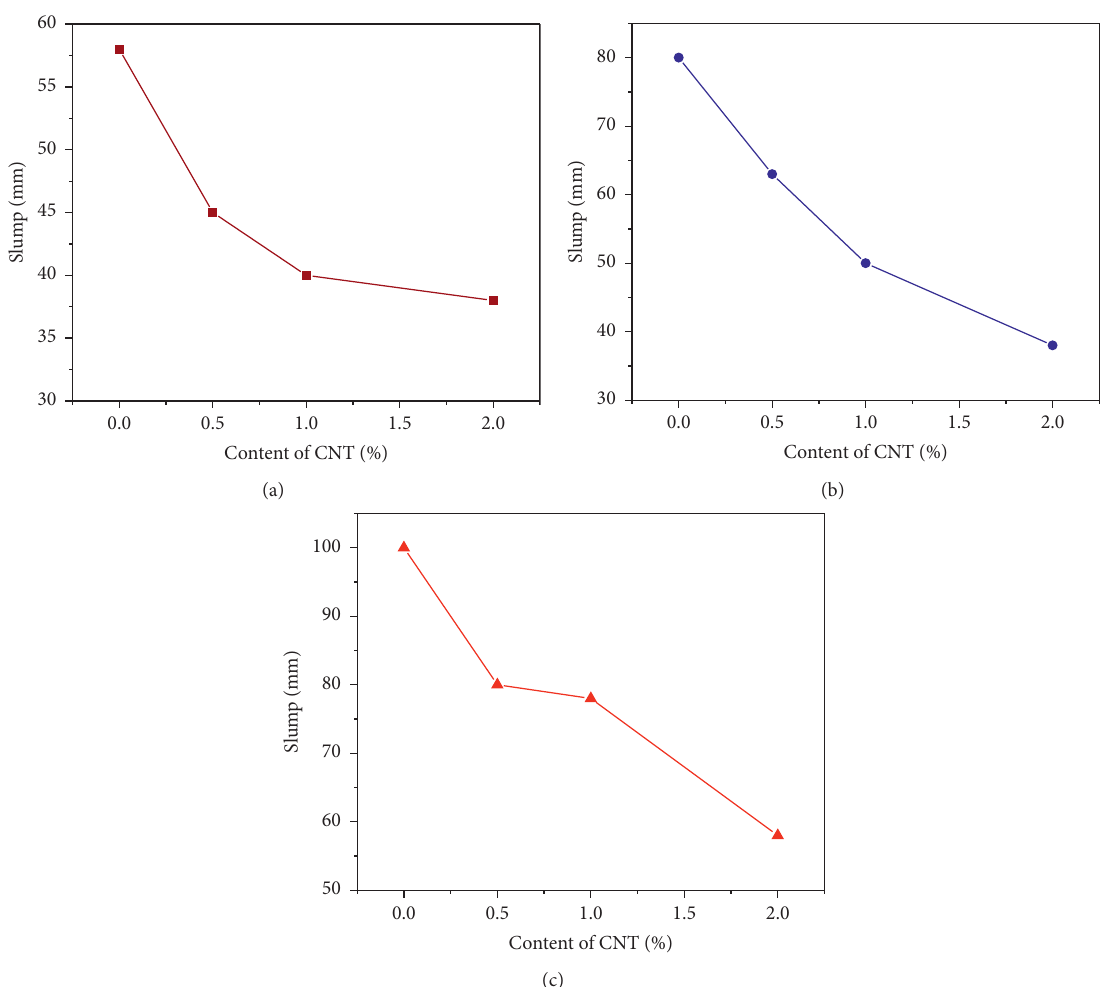
Figure 7: Effect of CNT dosage and water/cement on the measured minislump [67]: (a) w/b � 0.4, (b) w/b � 0.5, and (c) w/b �